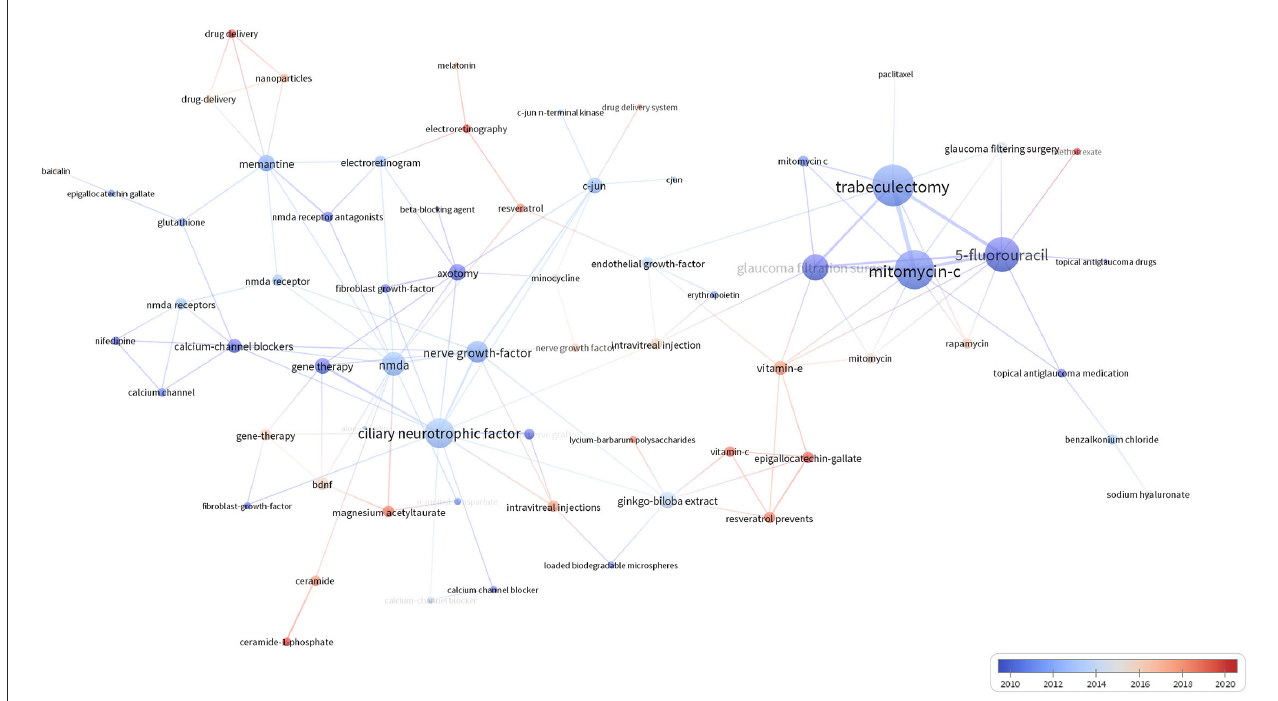
FIGURE9 The width of the line between the nodes indicates the strength of the association between the